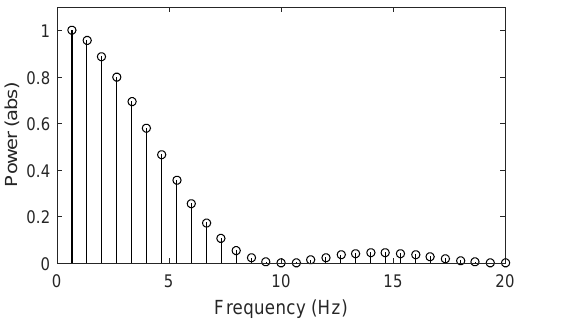
Figure 3: Operation principle of combined frequency